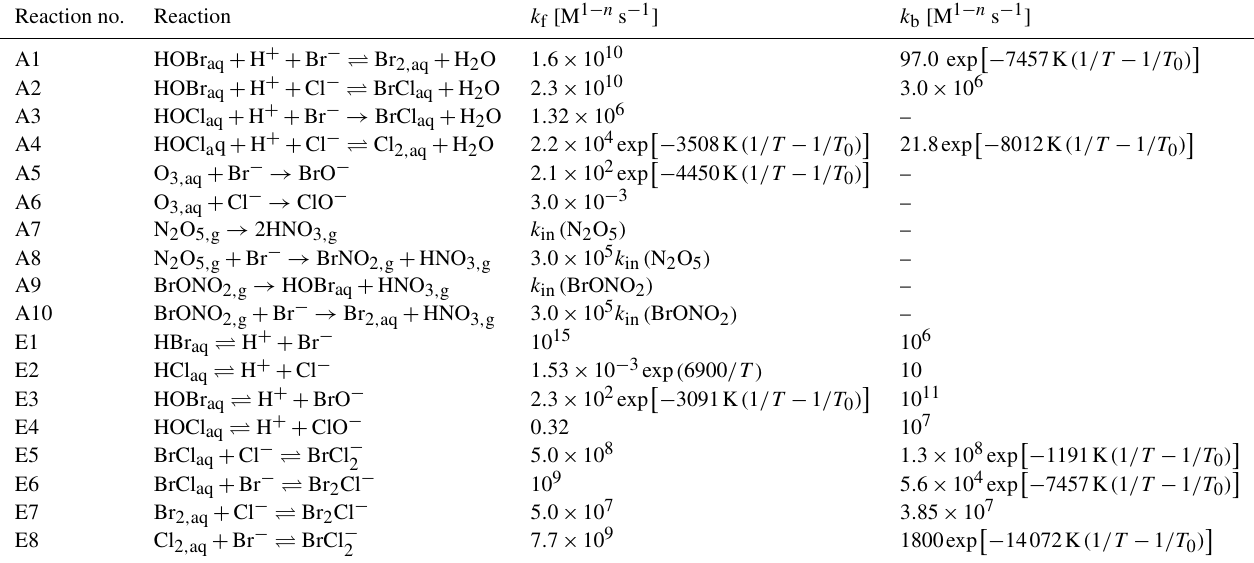
Table A4. Reactions occurring in the liquid phase; forward reaction rate coefficients are shown as well as backward reaction rate constants, if applicable. k in (X) denotes the gas-to-aerosol transfer rate for species X (Eq. 8). T 0 = 298 . 15K is the room temperature. Reaction no.